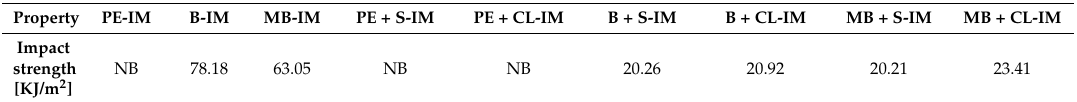
Table 4. Impact properties of the injection-molded (IM) systems (NB = no break occurred under these test